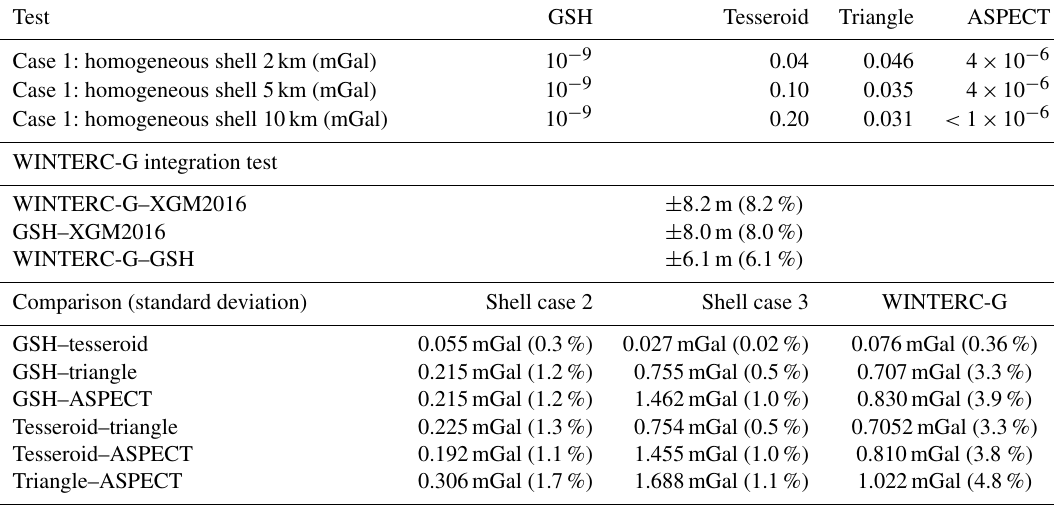
Table 5. A summary of the various benchmark tests described in this paper. Test GSH Tesseroid Triangle ASPECT Case 1: homogeneous shell 2km (mGal) 10 − 9 0.04 0.046 4 × 10 − 6 Case 1: homogeneous shell 5km (mGal) 10 − 9 0.10 0.035 4 × 10 − 6 Case 1: homogeneous shell 10km